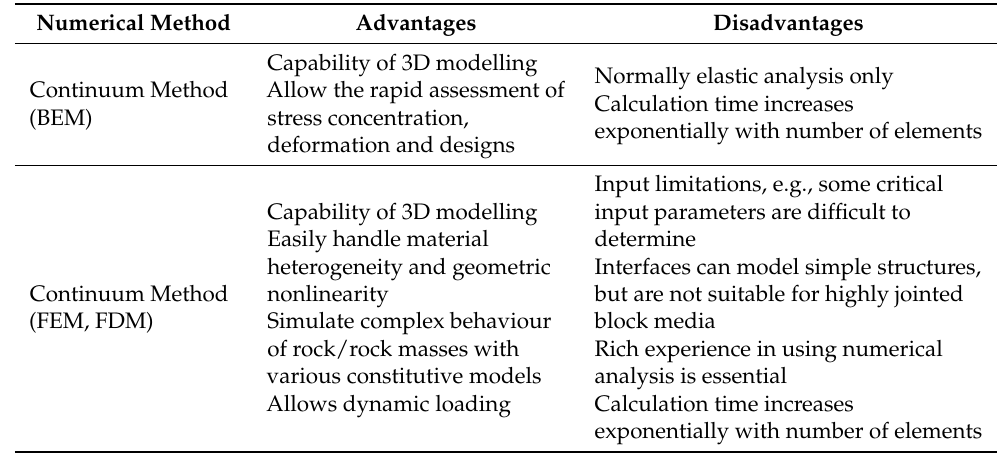
Table 1. Advantages and disadvantages of numerical methods in modelling rock burst